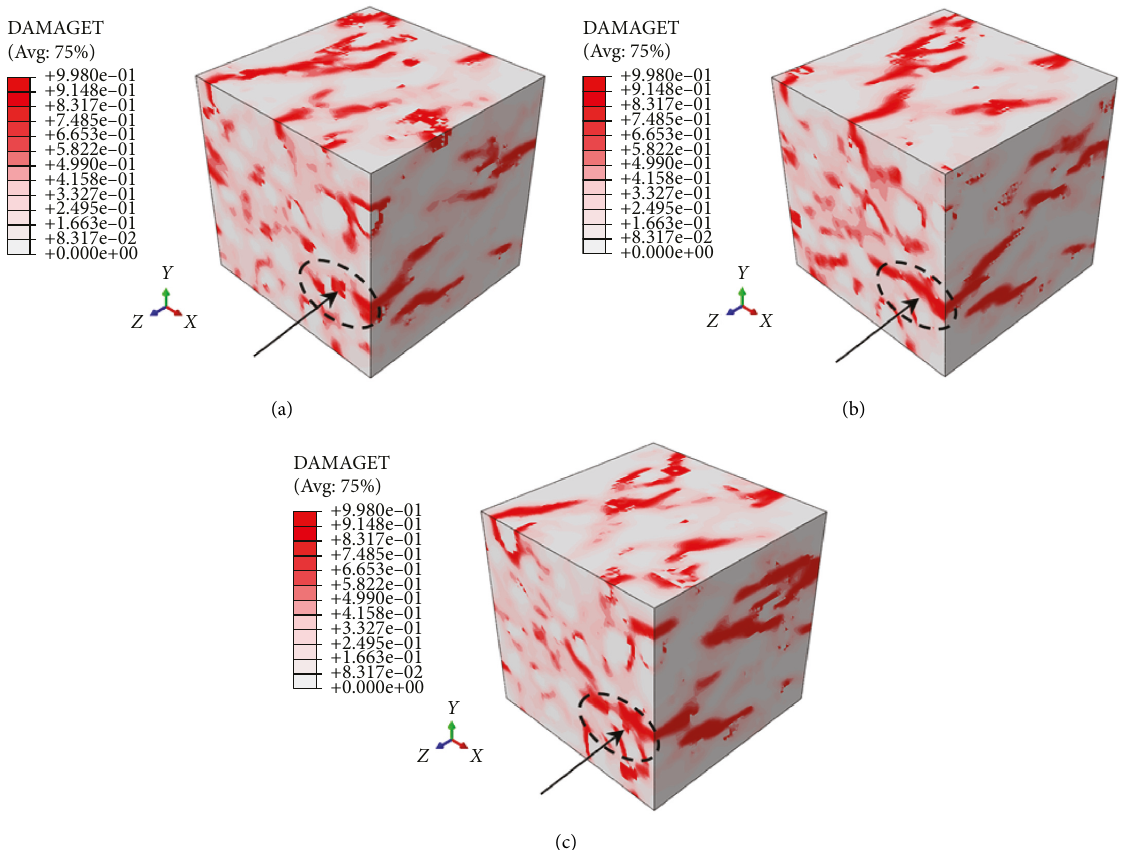
Figure 14: Tensile damage nephogram of concrete with different particle size of rubber. (a) Rubber side length is 2.5mm, (b) rubber side length is 3mm, (c) rubber side length is 3.5